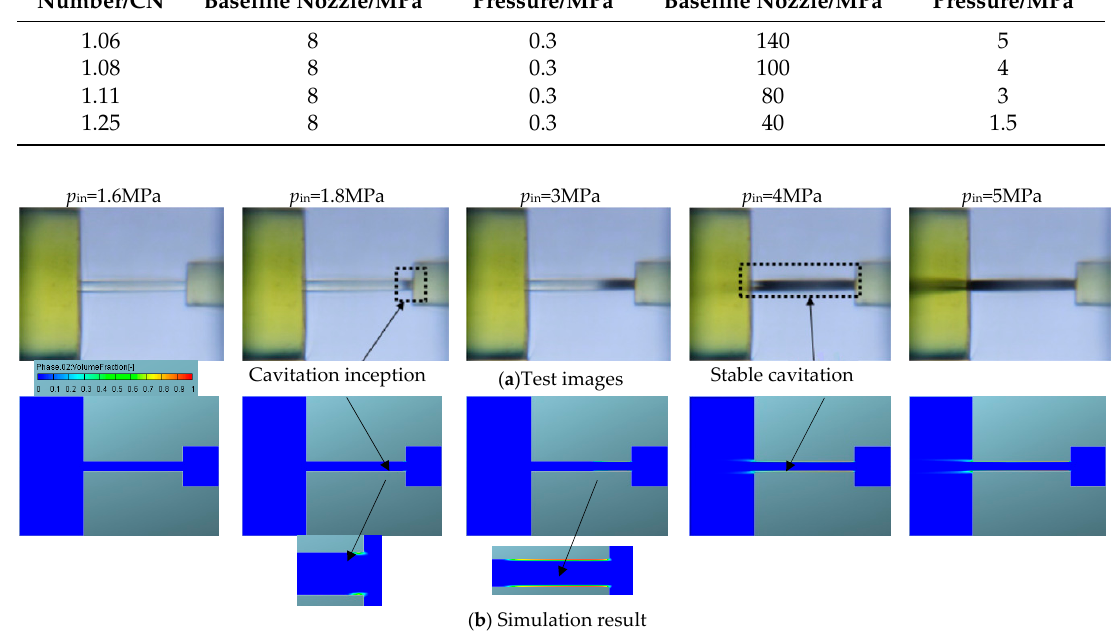
Figure 4. Comparison of experimental and simulation results ( p b =0.3MPa).